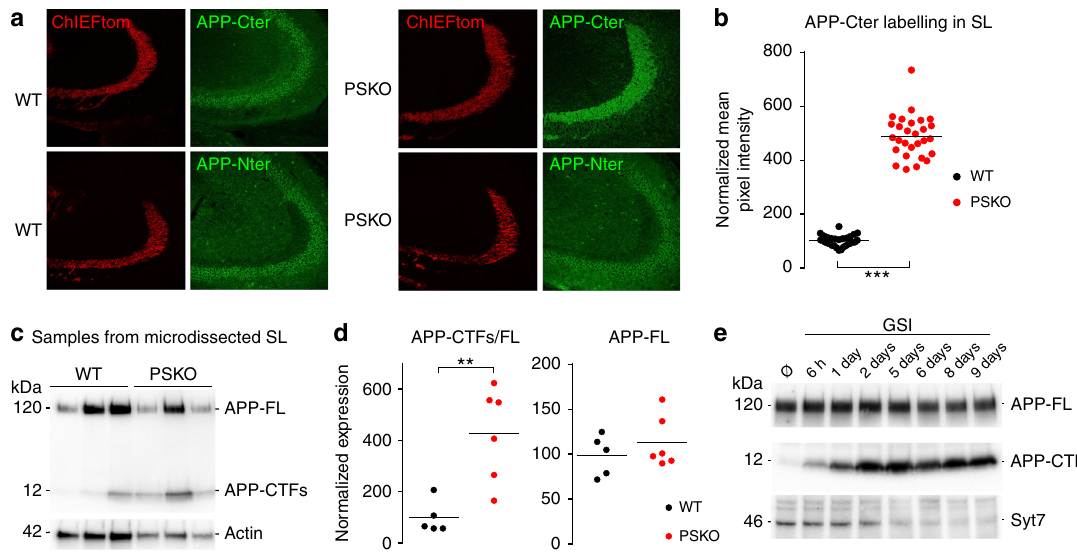
Fig. 6 γ -secretase proteolytic activity regulates the axonal expression of APP- β CTF. a Confocal images of the Mfs tracts distinguished in the red channel (ChIEFtom) and of stainings of APP Cterminal with Y188 antibody (upper panel) and Nterminal with JRD32 antibody (lower panel). In WT, Mfs are labelled with the Cterminal but barely with the Nterminal antibody. In PSKO, Mfs are strongly labelled with the Cterminal but not with the Nterminal antibody. b Scatter plots of the mean pixel intensity of APP-Cter in the SL normalized to the mean pixel intensity in the SR . A fi ve-time increase of the intensity is observed in PSKO condition compared to WT. c Samples prepared as in (Fig. 3c) show a striking increase in APP-CTFs levels in dissected Mfs detected with Y188 antibody against APP-Cter. d Quantitative analysis of western blot in c . A 400% increase in the expression of APP-CTFs was detected. e Western-blot of samples prepared from neuronal cultures treated with GSI from 6 h to 9 days in vitro. APP-CTFs accumulate while Syt7